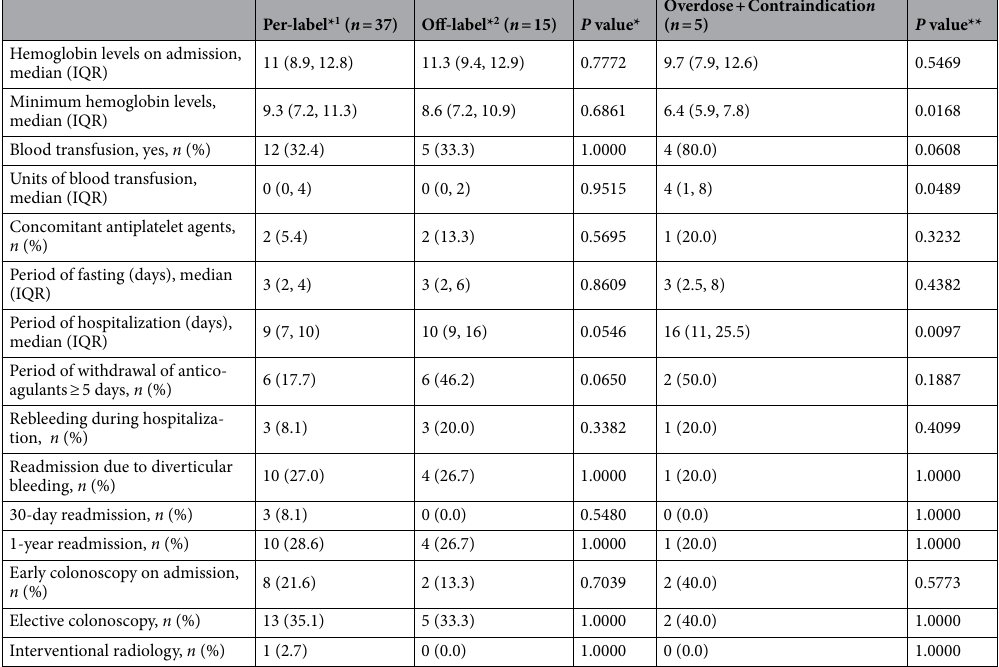
Table 6. Clinical outcomes in patients receiving DOACs at different doses. *1 Appropriate standard-dose + appropriate low-dose, *2 Overdose + underdose. *Compared per-label with off-label, **compared per-label with overdose and